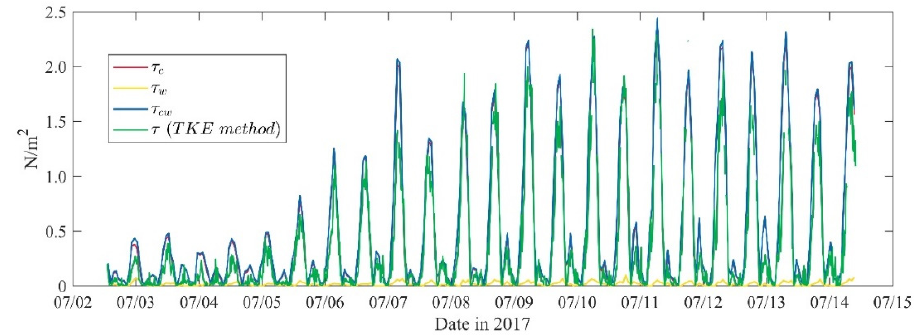
Figure 2. Calculation of bed shear stress, comparison between Grant–Madsen method and the TKE method. The red and blue lines largely overlap because the wave-induced shear stress (yellow line) is very small.